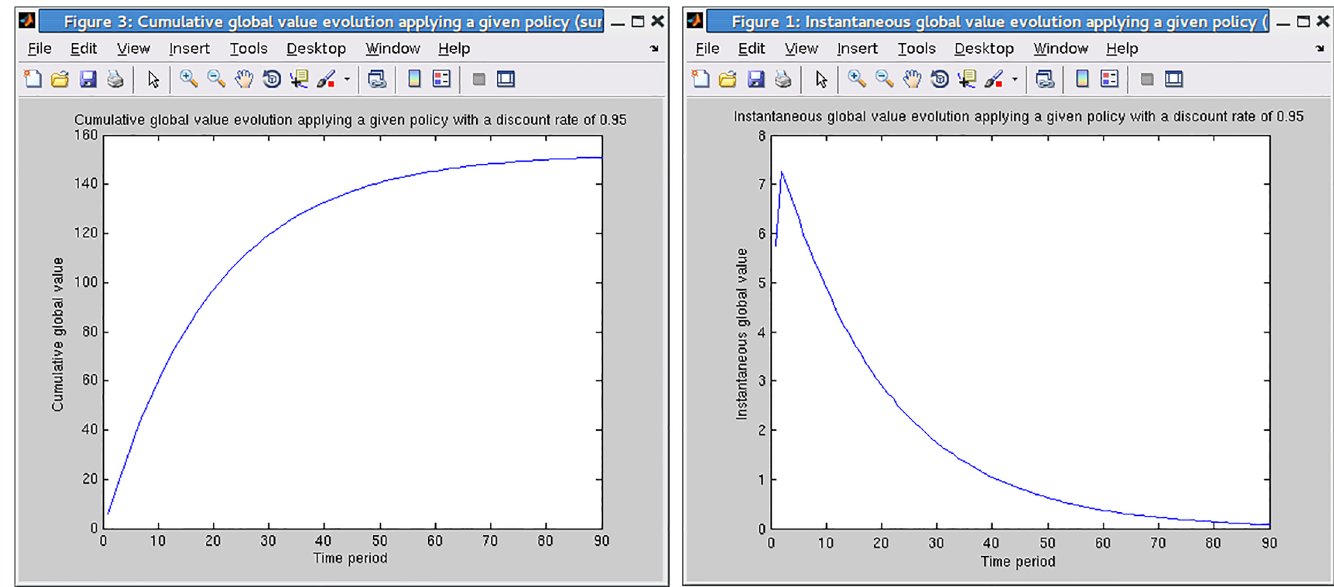
Fig 3. Toy epidemics management problem: (A) cumulative and (B) instantaneous discounted global reward of the GMDP policy, estimated by Monte Carlo simulation.